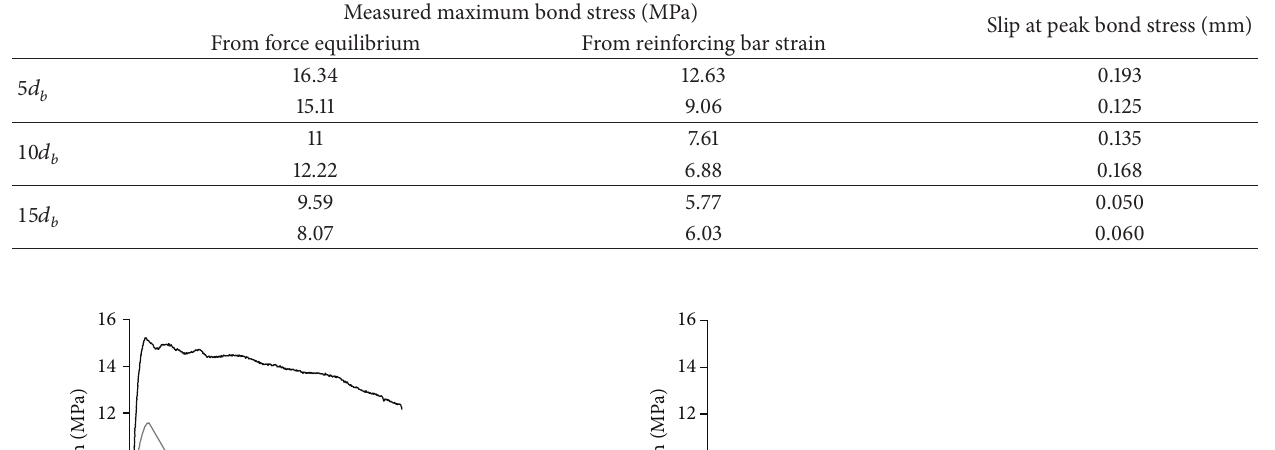
Table 1: Experimental bond strength and slip at peak stress.